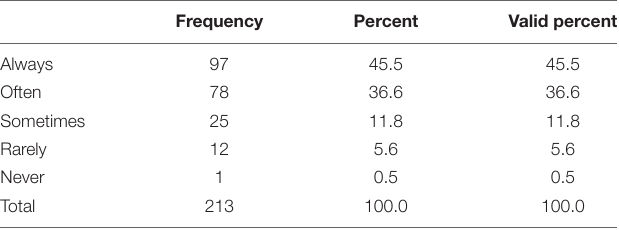
TABLE 6 | I use English for any type of communication during work hours.